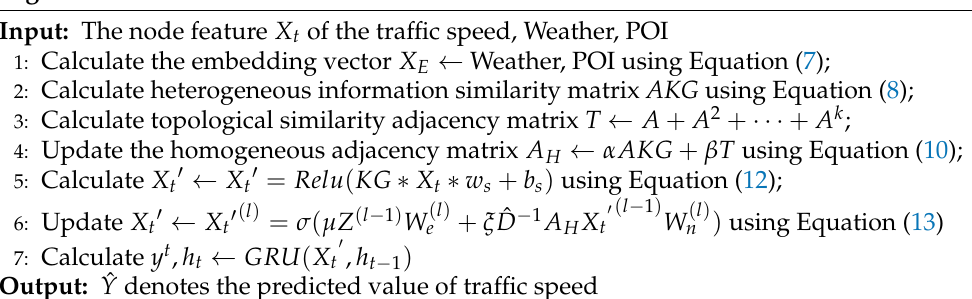
Algorithm 1 HIT-Cell of